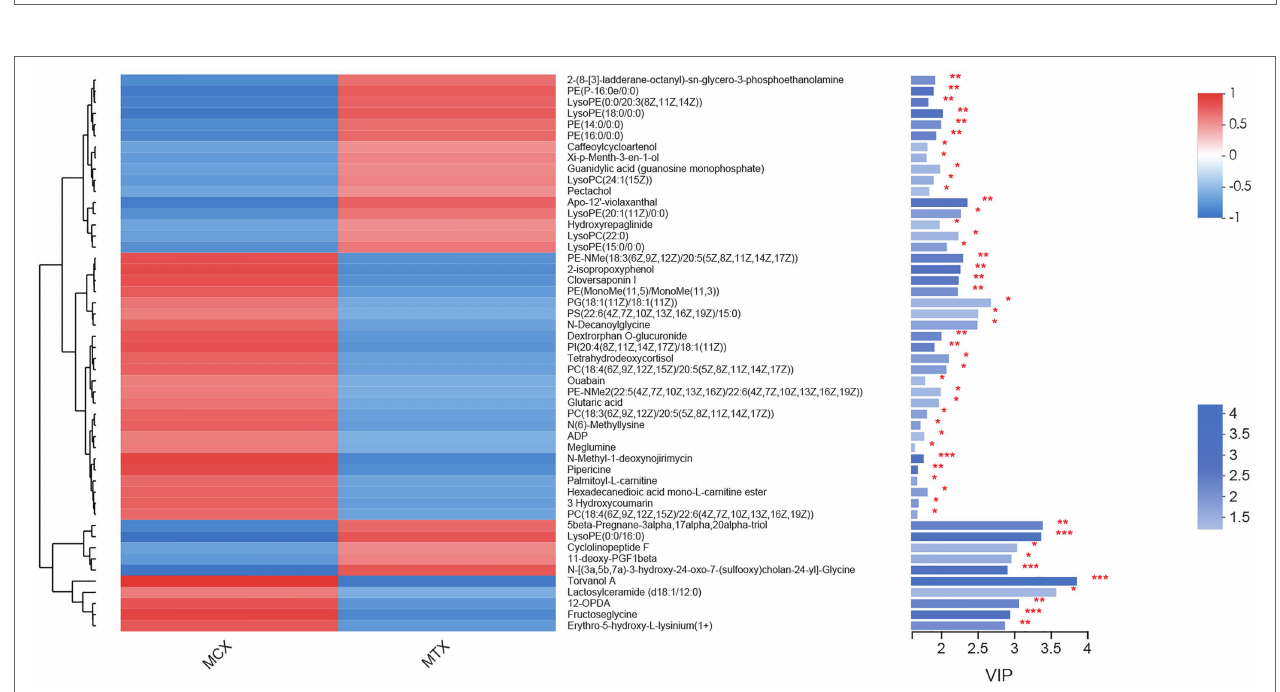
FIGURE 3 | Compound classification in the Human Metabolome Database (HMDB). The different colors in each pie chart in the figure represent different HMDB categories, and the area represents the relative proportion of metabolites in that category.